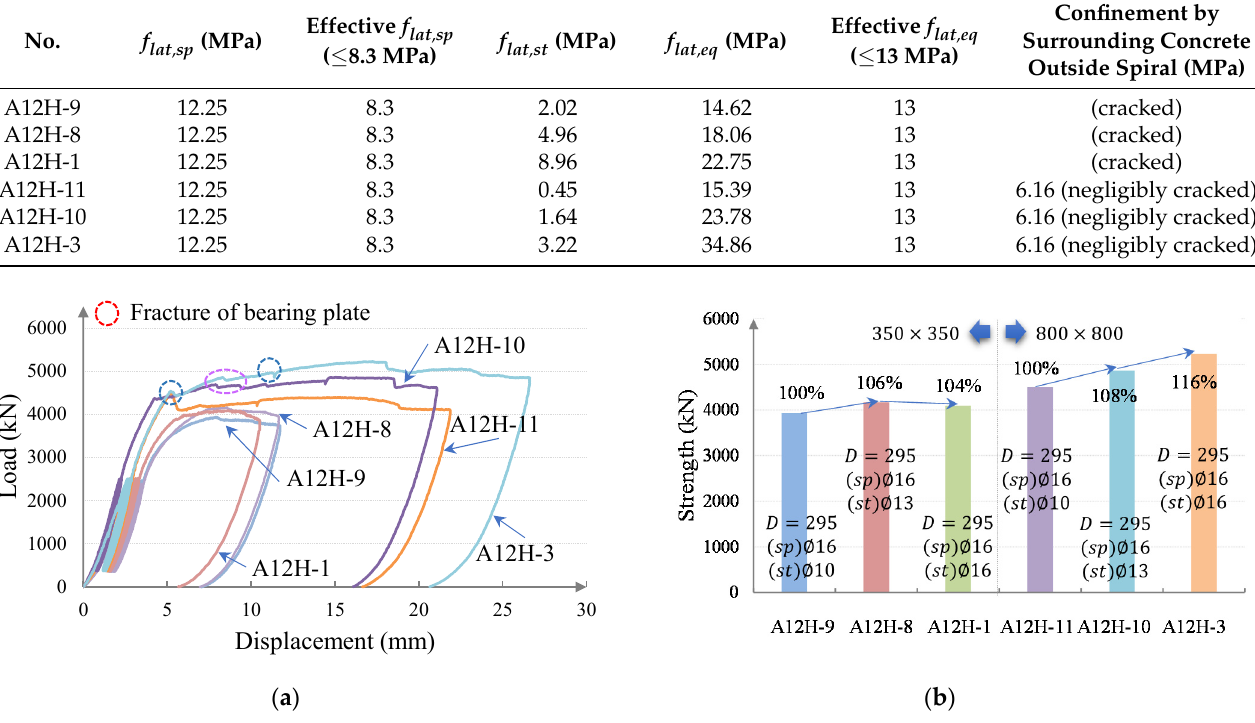
Figure 10. Test results of group 3 specimens: ( a ) load-displacement curve; ( b ) ultimate bearing strength. Table 5. Lateral confinement of group 3 specimens.